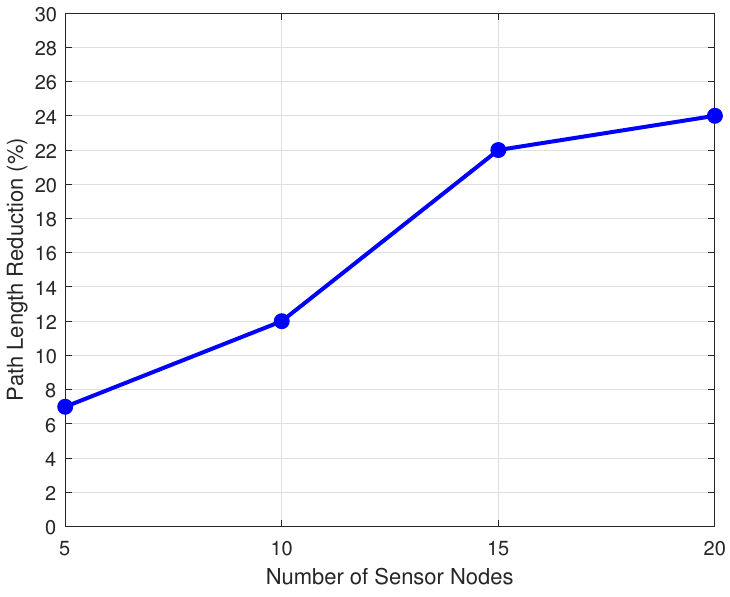
Figure 18. Reduction in traveled distance of S 1 compared to S 4